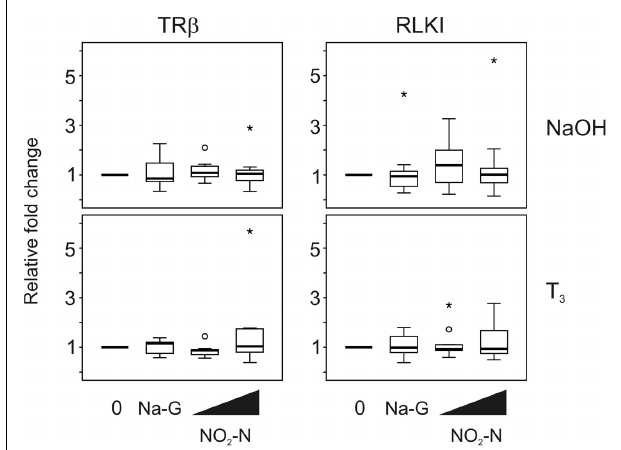
FIGURE 2 | QPCR analysis of thyroid hormone receptor β ( TR β ) and Rana larval keratin I ( RLKI ) transcript levels in the C-fin assay after exposure to nitrite in the absence or presence of 10nMT 3 . Tail fin biopsies were exposed to vehicle control (water; 0) and the indicated test chemicals for 48h in the presence of 400nM NaOH or 10nMT 3 in 400nM NaOH solvent.Test chemical concentrations were 5mg/L sodium control (in the form of sodium gluconate, Na-G), 0.5 and 5mg/L NO 2 –N (in the form of NaNO 2 ).The results are expressed as fold change relative to the vehicle control (NaOH; upper panels) or to the vehicle + T 3 -induced levels (lower panels) and represent QPCR data from n = 7–12 animals. Increasing concentrations of test chemicals are represented by bevels. See Figure 1 legend for more details.